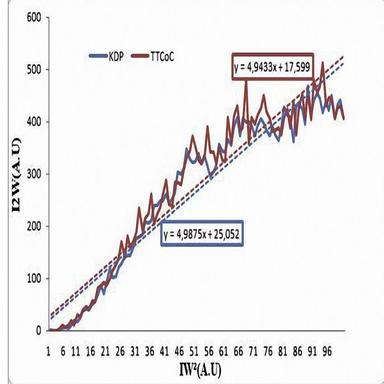
I2W versus IW2 for tetrakis(thiourea)cobalt chloride (TTCoC) and potassium dihydrogen phosphate (KDP) single crystals.